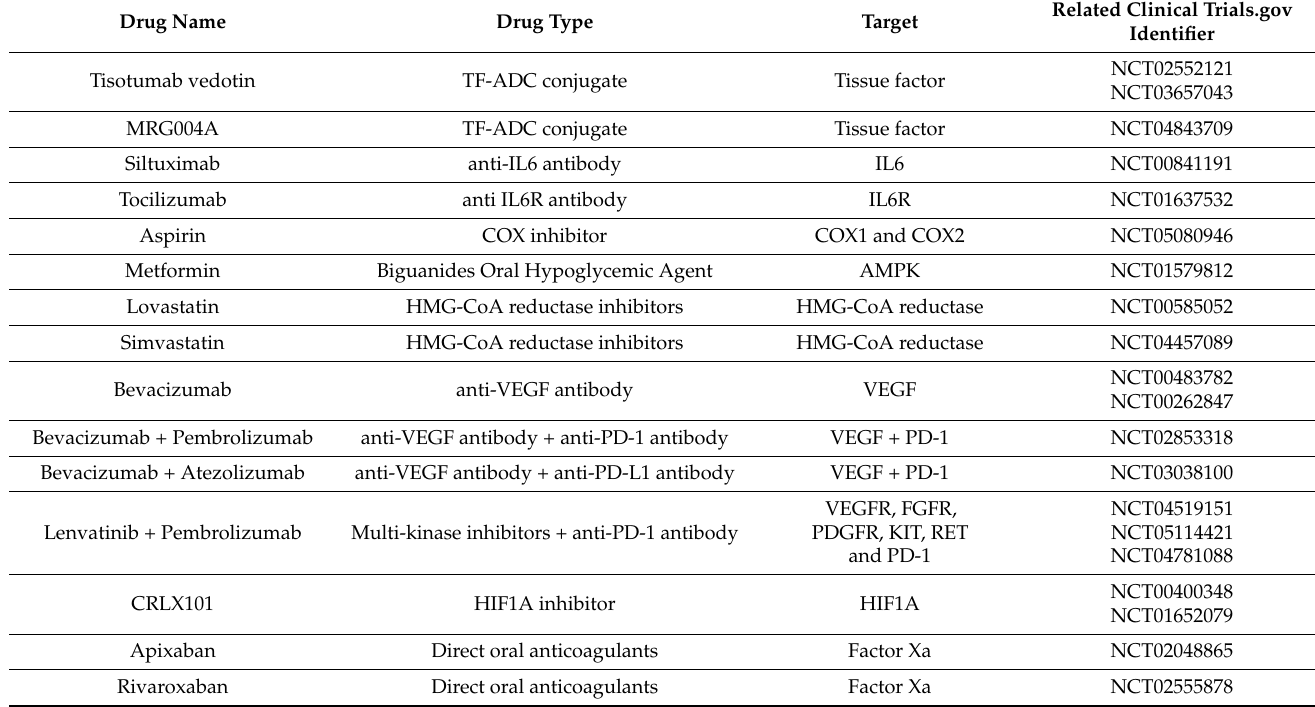
Table 3. Candidate of therapeutic drugs targeting focused on